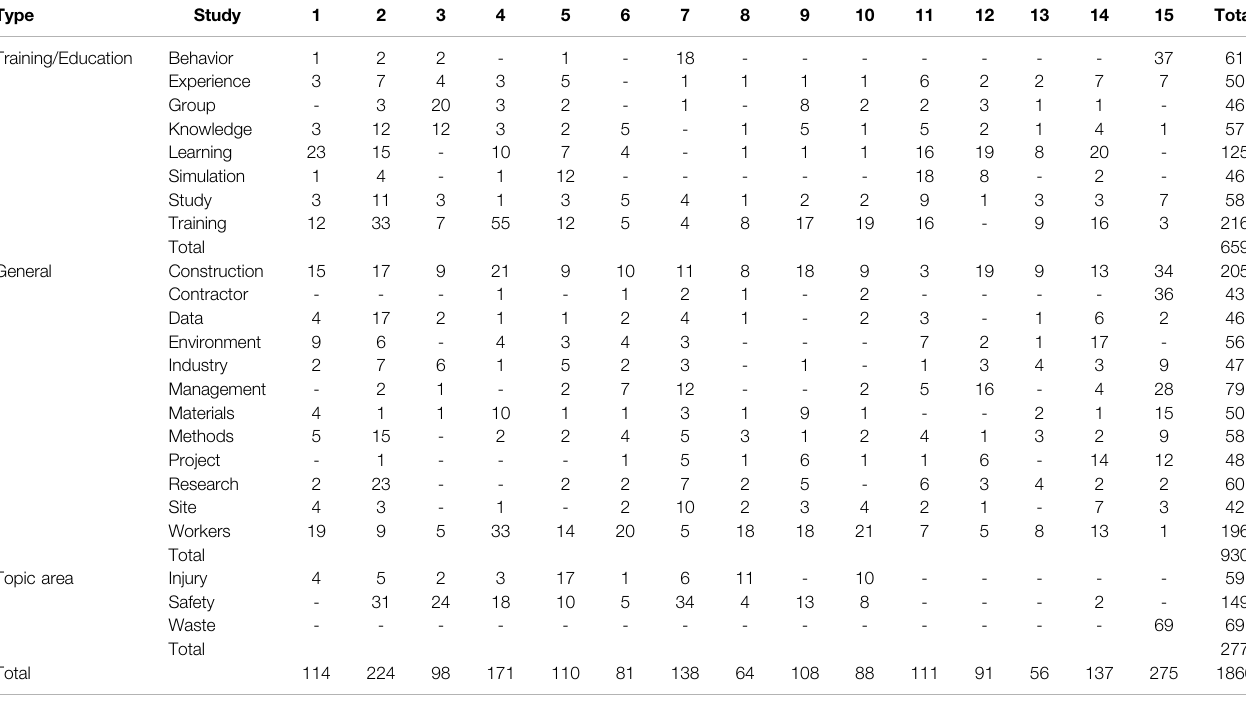
TABLE 4 | Frequency of terminology in evaluated studies by term type.